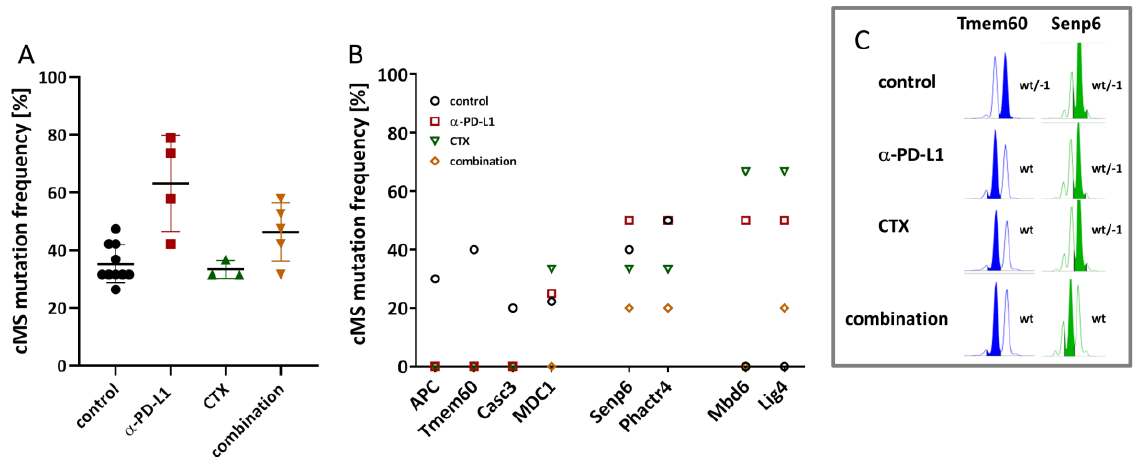
Figure 7. cMS mutation frequency. ( A ) Fragment length analysis was used to detect frameshift mutations in selected cMS. Overall mutational frequency in residual tumors revealed higher mutational load after α -PD-L1 monotherapy and the combination. ( B ) The cMS mutation frequency in selected Mlh1 − / − target genes differed among the four therapy groups. In some genes, the results even indicated loss of single cell clones (APC, Tmem60, and Casc3). ( C ) Representative band shifts of two cMS loci in Tmem60 and Senp6 target genes. Wt—wildtype; wt/ − 1—wildtype/ − 1 s .